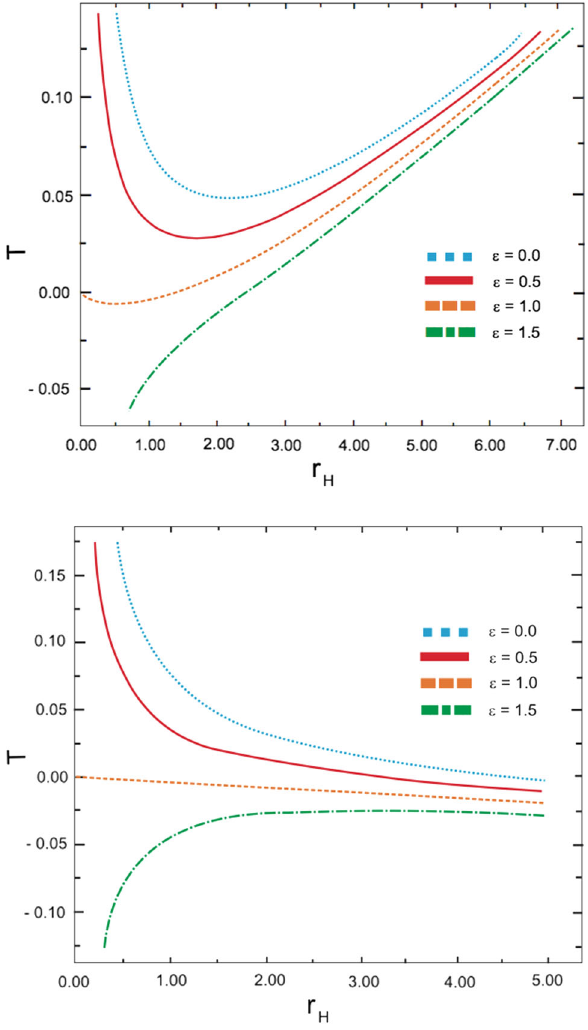
Fig. 2 Graphs for T × r H . In the upper panel, N = 0 . 5 and in the lower panel, N =